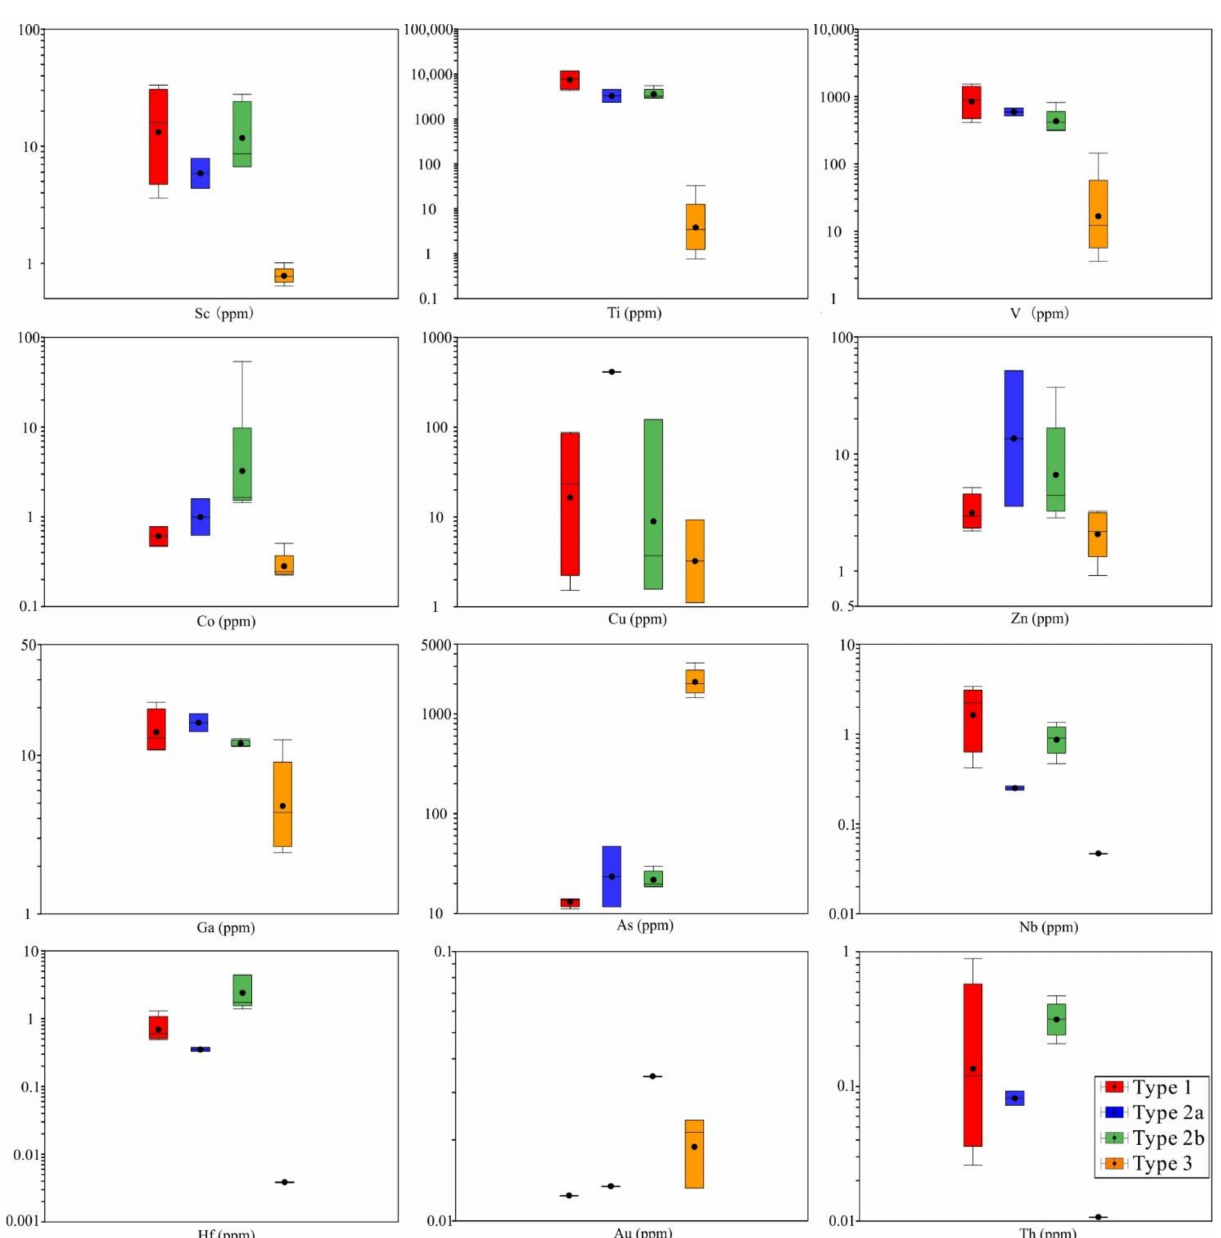
Figure 9. Box-plots of trace elements in different garnets from the Laoshankou deposit. The normalized multi-element diagram shows that all garnets in Laoshankou are generally depleted in large ion lithophile elements (LILEs, e.g., Rb, Sr, and Ba) relative to the average primitive mantle [59]. However, high field strength elements (HFSE) show a more consistent variation with major element geochemistry and petrographic observations. Both Type 1 and Type 2 garnets have higher U, Th, Hf, Y, and Ti, compared to the average primitive mantle (Figure 10). In contrast, Th, Nb, Hf, Y, and Ti compositions of Type 3 garnet are lower than the average primitive mantle (Figure